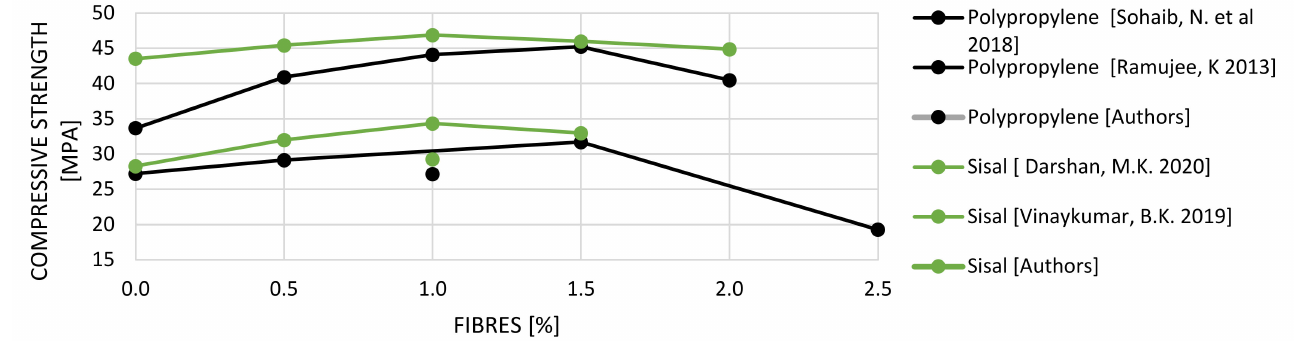
Figure 5. Impact in the compression strength of different mix designs according to the fiber